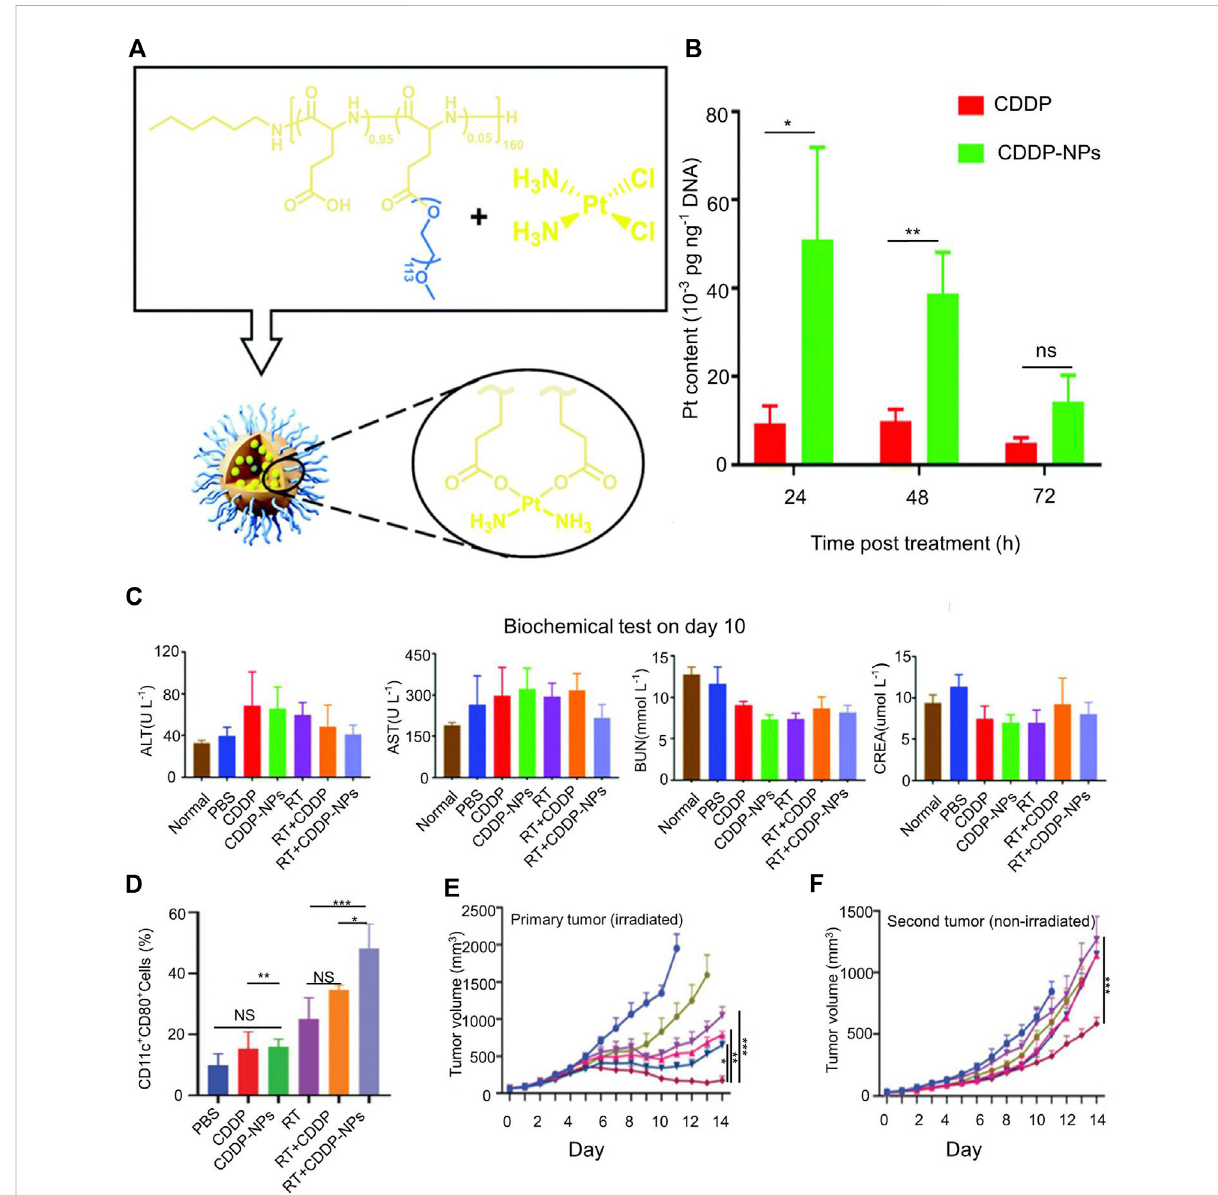
FIGURE 1 Cisplatin nanoparticles boost abscopal effect. (A) Structure of cisplatin (CDDP) loaded poly (l-glutamic acid)-graft-methoxy poly (ethylene glycol) complex nanoparticles (CDDP-NPs). (B) The Pt content in the tumor DNA of differentially treated mice on the basis of CDDP for 24, 48, and 72 h. (C) Serum levels of alanine aminotransferase (ALT), aspartate aminotransferase (AST), blood urea nitrogen (BUN) and creatinine (CREA) in the indicated groups on day 10. (D) The population of activated DCs in tumors was evaluated on day 9 in vivo . (E) The tumor volume of primary tumor. (F) The tumor volume of distant tumor. Reproduced with permission from (Wang et al.,